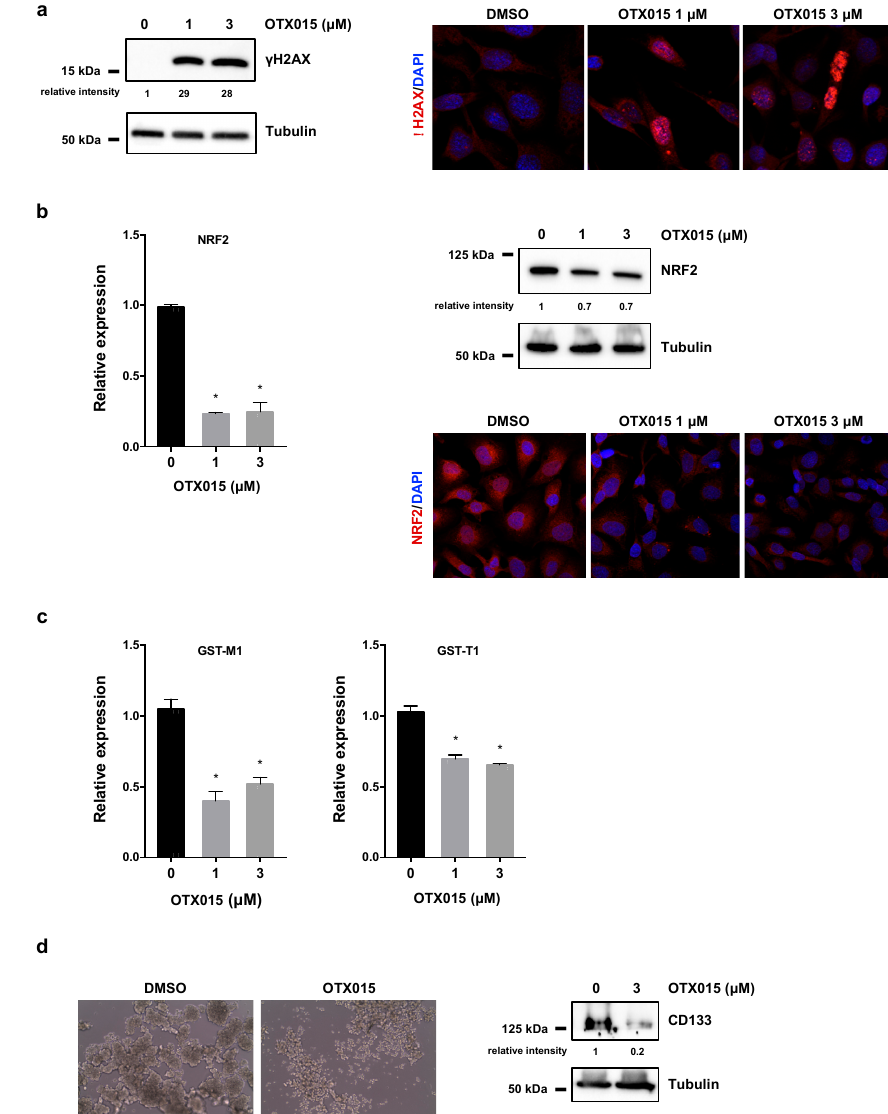
Figure 3. BET inhibition induces DNA damage and perturbs tumor spheroid architecture. ( a ) WB analysis (left panel) of γ H2AX in SKOV3 cells treated with OTX015 (0–1–3 µ M) for 72 h. Tubulin served as internal control. IF experiments (right panel) showing the presence of γ H2AX foci (red) in OTX015 treated (1 and 3 µ M) cells. DMSO was used in control cells. Nuclei (blue) were visualized with DAPI staining. Representative images captured under ApoTome microscope at 40 × magnification. ( b ) q-PCR analysis of NRF2 mRNA levels (left panel) in SKOV3 cells exposed to OTX015 (0–1–3 µ M), graphed as fold increase over not-treated cells, set at 1. β -actin mRNA was used as endogenous control. Histograms indicate mean values ± SD of two independent experiments, each performed in triplicate. Statistical significance vs. control cells was calculated by one-way ANOVA (* p < 0.05). WB experiments (upper right panel) performed on protein extracts from SKOV3 cells treated with OTX015 (0–1–3 µ M) for 72 h. Tubulin served as loading control. IF experiments (lower right panel) showing the downregulation of NRF2 protein expression (red) in OTX015-exposed (1 µ M and 3 µ M) cells respect to untreated SKOV3 samples. ( c ) Transcript levels of GST-M1 and GST-T1 genes by q-PCR analysis in SKOV3 cells exposed to OTX015 (0–1–3 µ M) and graphed as fold increase over not-treated cells, set at 1. β -actin mRNA was used as endogenous control. Histograms indicate mean values ± SD of two independent experiments, each performed in triplicate. Statistical significance vs. control cells was calculated by one-way ANOVA (* p < 0.05). ( d ) OTX015 alters spheroid formation in SKOV3 cells cultured in 24-well ultralow attachment plates with DMEM-F12/B27/EGF/FGF medium. Cells were photographed under a light microscope at 20 × magnification (left panel) after 10 days of 3 µ M OTX015 treatment (DMSO as control). WB of CD133 protein levels (right panel) in OTX015-exposed (0–3 µ M) spheroids. Tubulin served as loading control. The original Western Blot images can be found in Figure